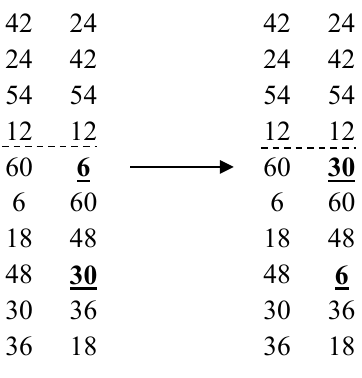
Figure 1. The within-slice exchange procedure. Left: The original FSLH(4,6;2,2). Right: The neighbour of the FSLH after exchanging 6 and 30 in the second slice and in the second column of the